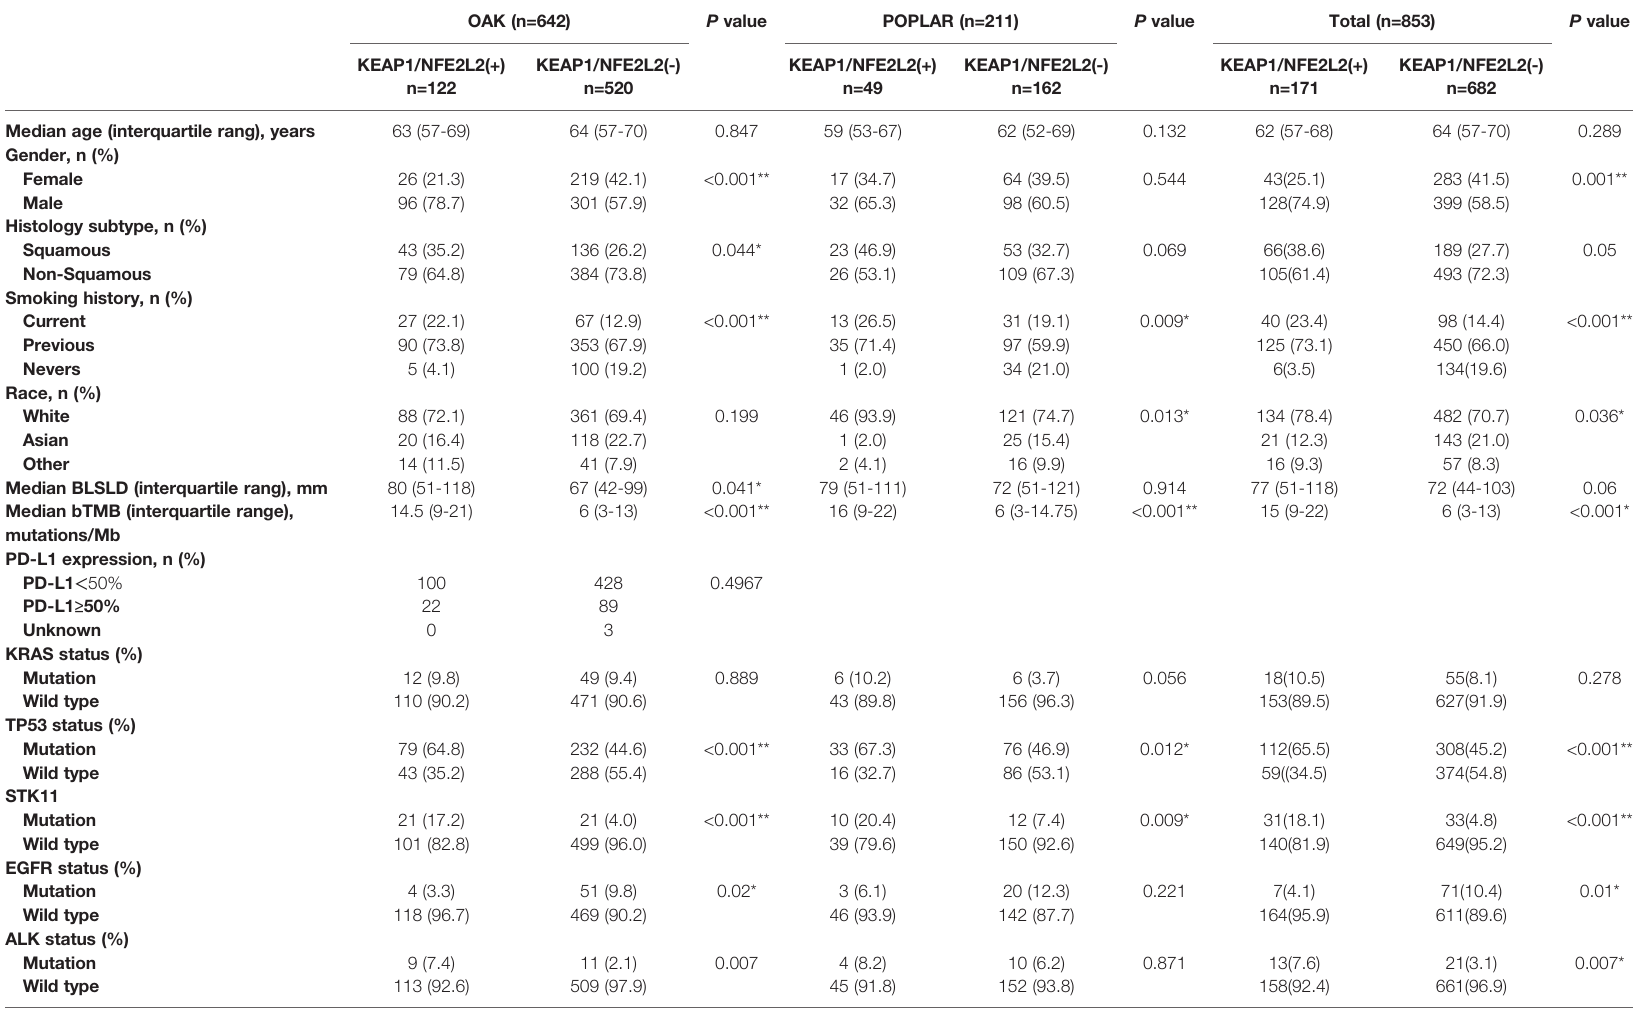
TABLE 1 | Clinical characteristics of patients with NFE2L2/KEAP1 mutations treated with atezolizumab or docetaxel in the OAK/POPLAR cohorts.